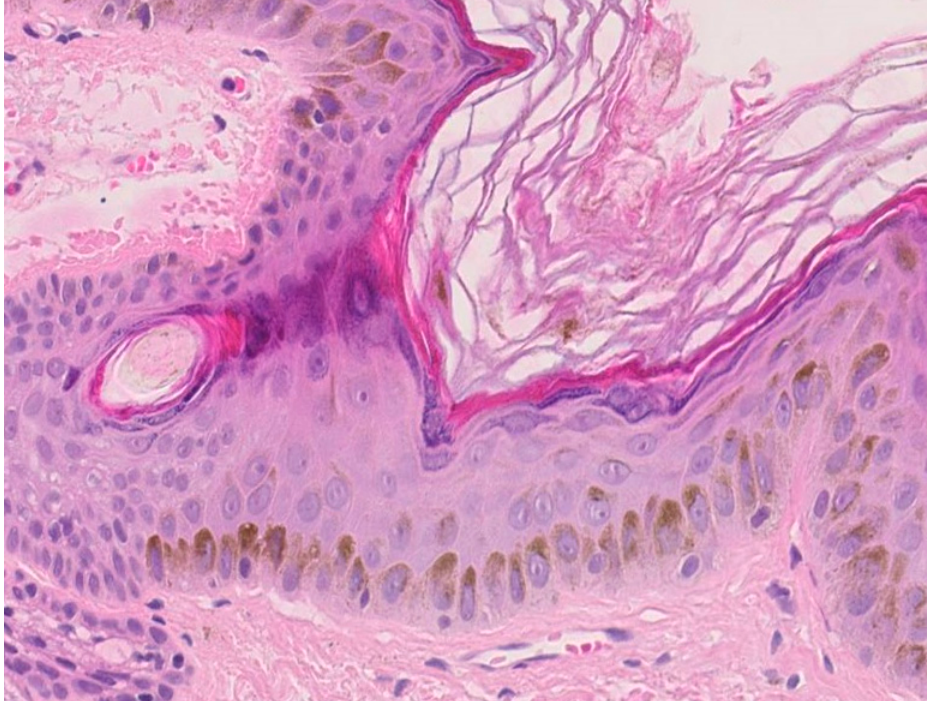
Figure 3. Human epidermis after solar irradiation (magnification × 120, HES stain). UVB light stimulates melanin secretion which acts as a built-in sunscreen. Epidermal melanin is a primary absorber of ultraviolet radiation, thus protecting the underlying epidermal and dermal elements.